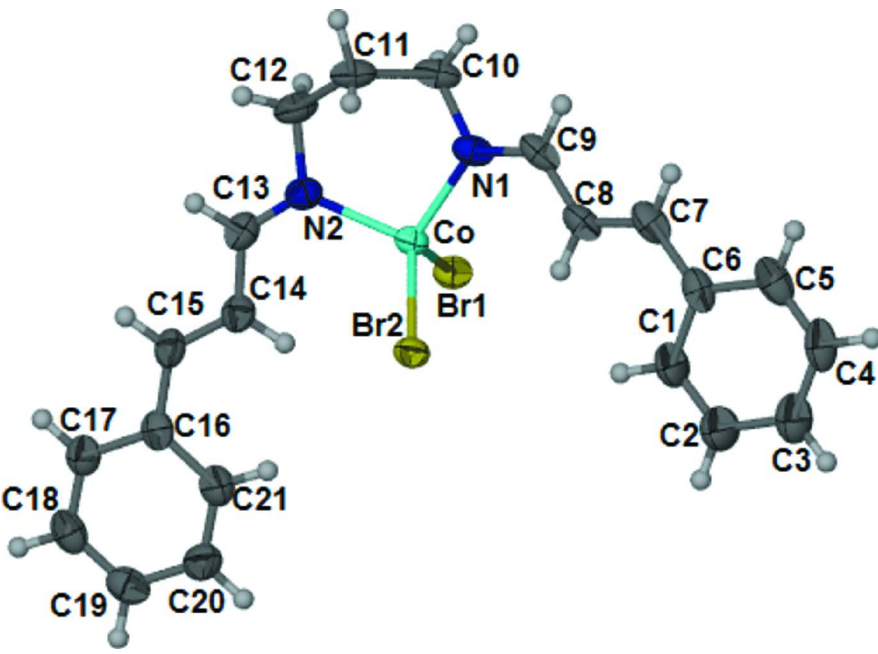
Thermal ellipsoid plot (Barbour, 2001) of the title complex at 70% probability level. Hydrogen atoms are drawn as spheres of arbitrary